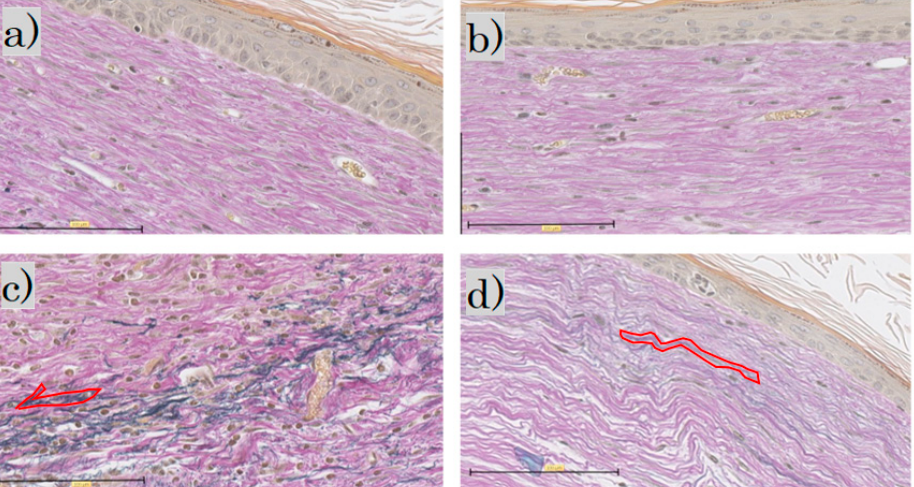
Figure 7. Elastica van Gieson staining: ( a ) control group; ( b ) FB group; ( c ) SS group; ( d ) LS group (scale bar 100 µ m). FB, fibroblasts; SS, short-term sphere-forming culture; LS, long-term sphere culture. One typical purple-stained elastic fiber is circled in